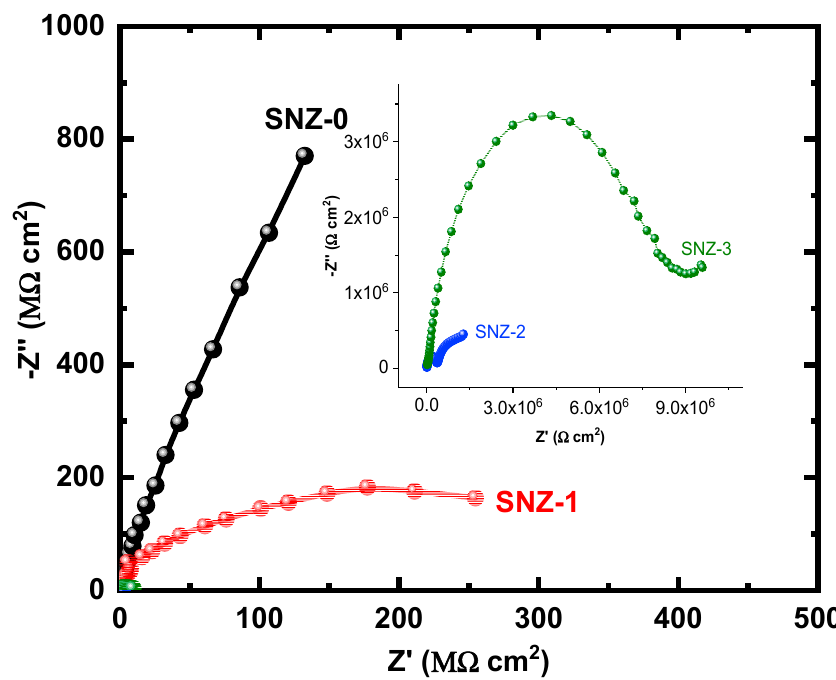
Figure 6. Nyquist plots of the coatings after 10 days’ immersion in a 3.5% NaCl solution.